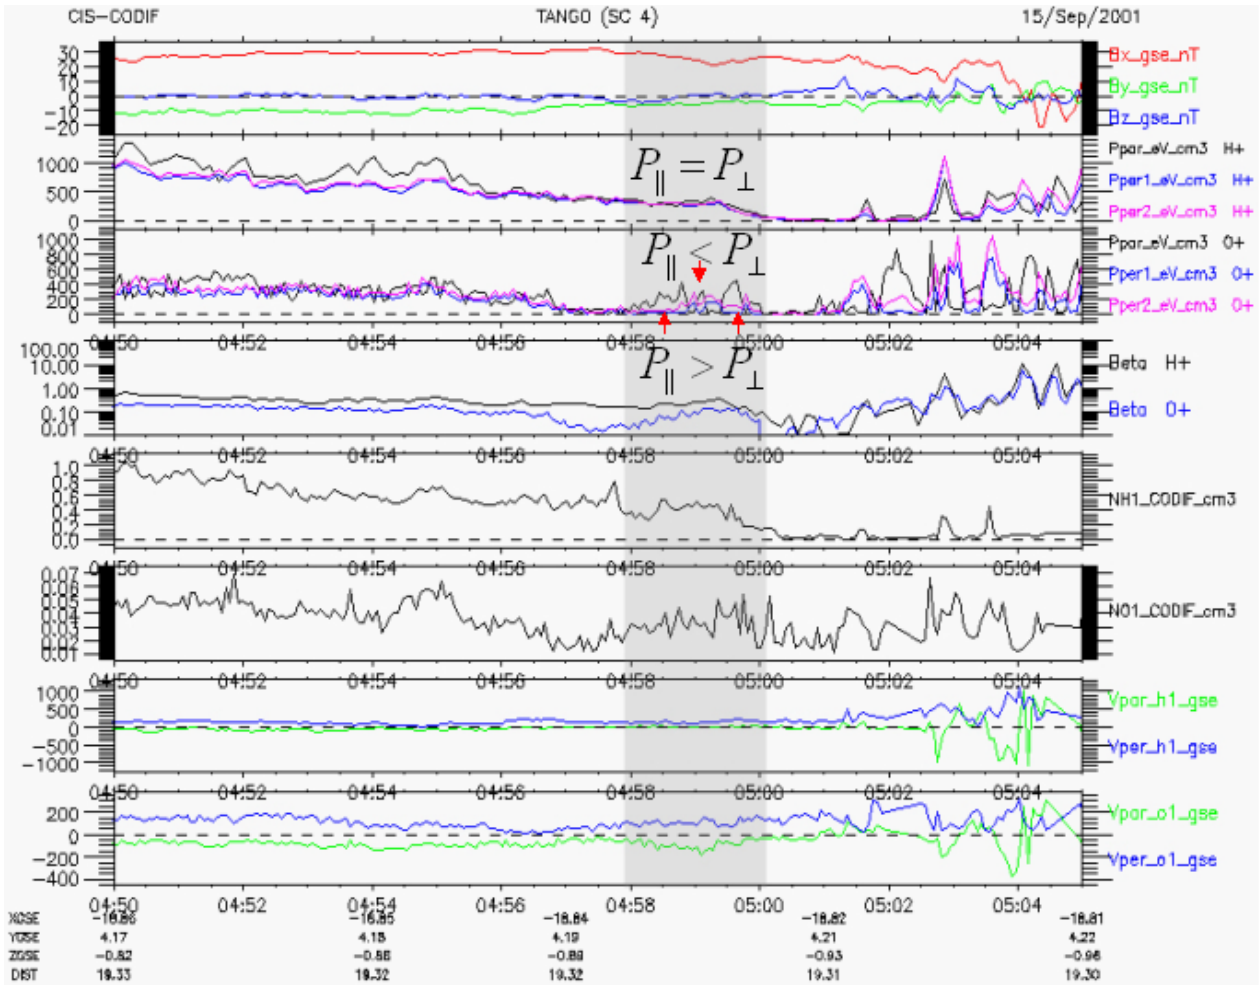
Fig. 8. 3-D momenta of proton and oxygen ions from C4. (a) the components of magnetic field. (b) and (c) are the pressure components. (d) is the beta value. (e) and (f) are the densities. (g) and (h) are bulk